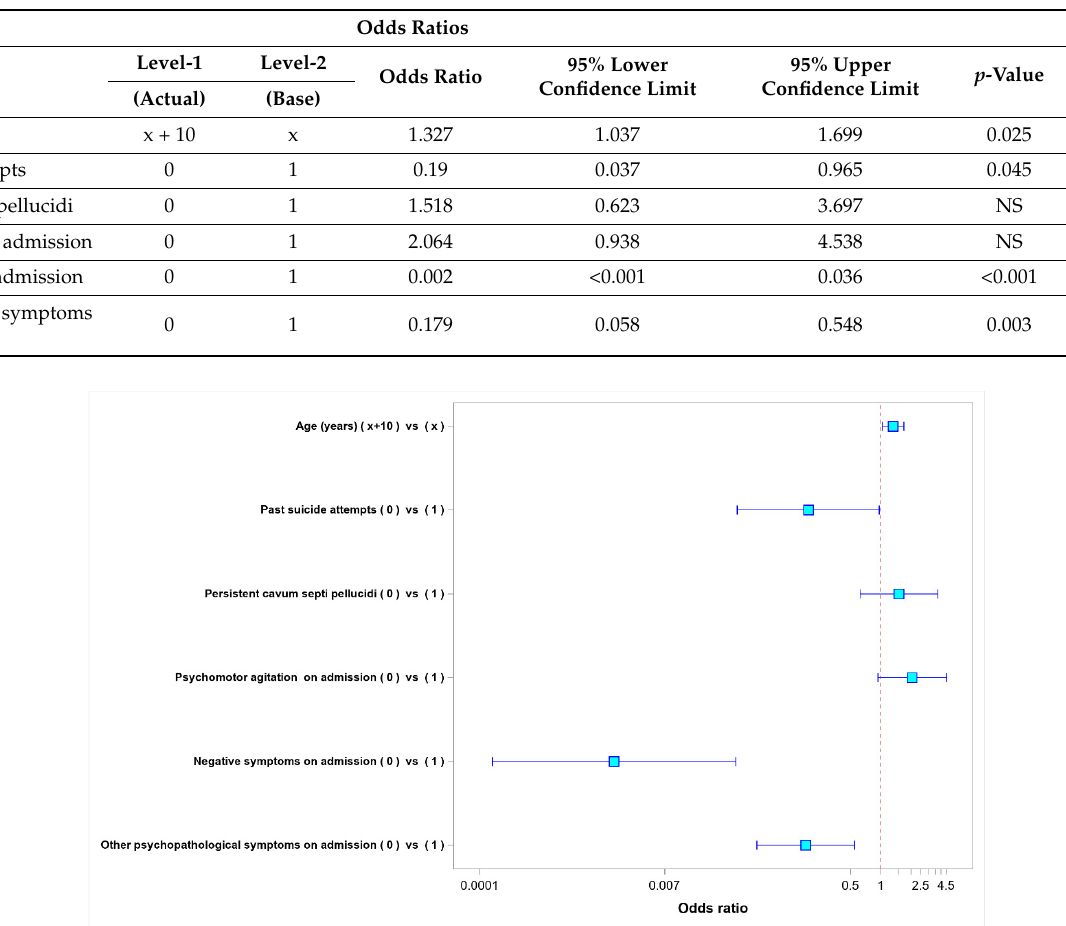
Figure 5. Odds ratio values for the parameters affecting the presence of negative symptoms at hos- pital discharge. Other psychopathological symptoms were present in 320 patients (94.67%) on admis- sion; at discharge, such symptoms were still present in 205 patients (64.06% out of the 320 patients who had had other psychopathological symptoms on admission). Older age and a higher numbers of past hospitalizations increased the risk of sustained other psycho- pathological symptoms at hospital discharge. Other risk factors for sustained other symp- toms at discharge were also shown to be a positive family history of alcohol abuse/de- pendence, the lack of affect dysregulation on admission, stable mood on admission, no anxiety on admission, the presence of negative symptoms, and other psychopathological symptoms on admission. The presence of persistent CSP lowered the risk of sustained other psychopathological symptoms at hospital discharge. The results of a multivariate analysis for the variables affecting the risk of other psychopathological symptoms being present at discharge have been shown in Table 4 and in Figure 6. Table 4. Multivariate model—odds ratio values for the parameters affecting the presence of other symptoms at hospital discharge. Odds Ratios Factor